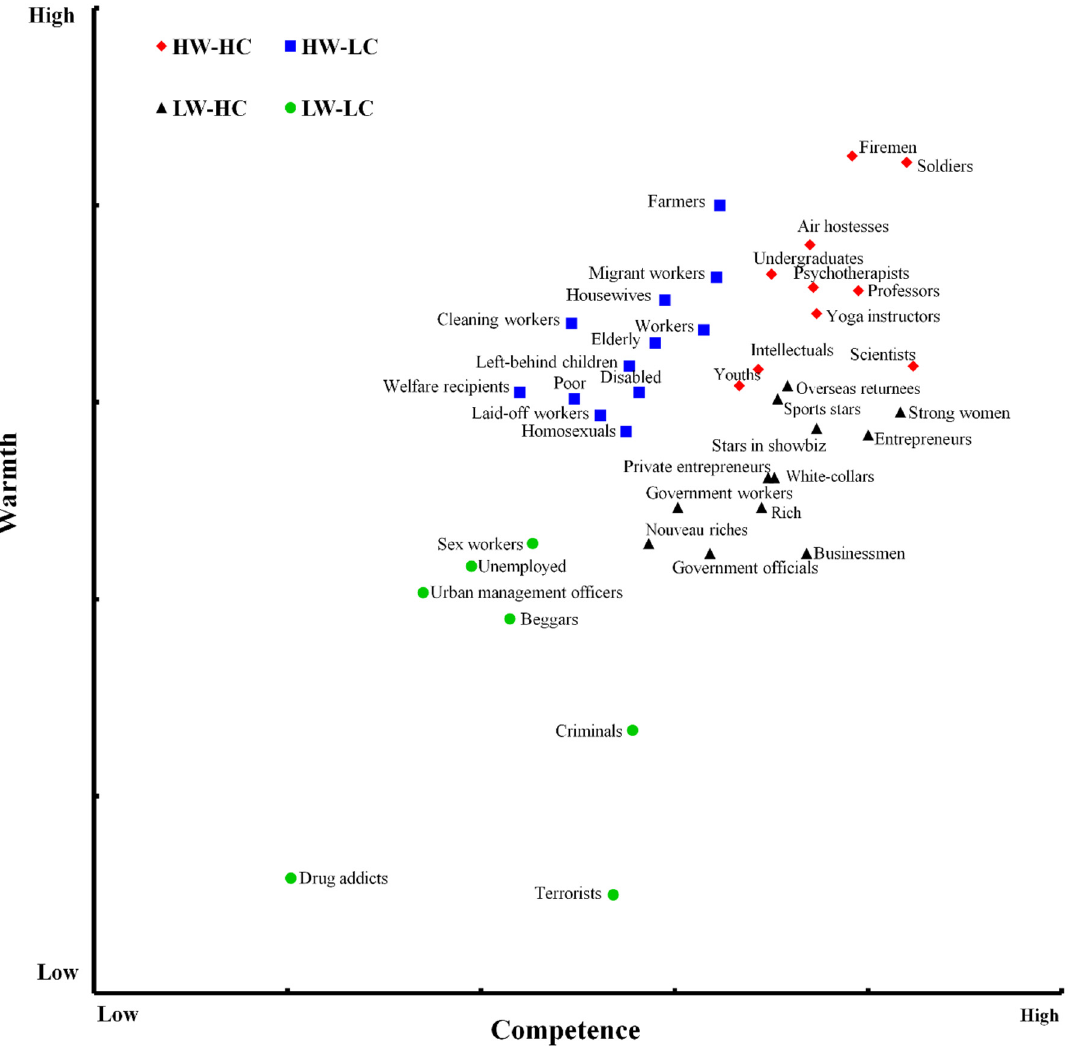
Figure 1. SCM map in mainland China.